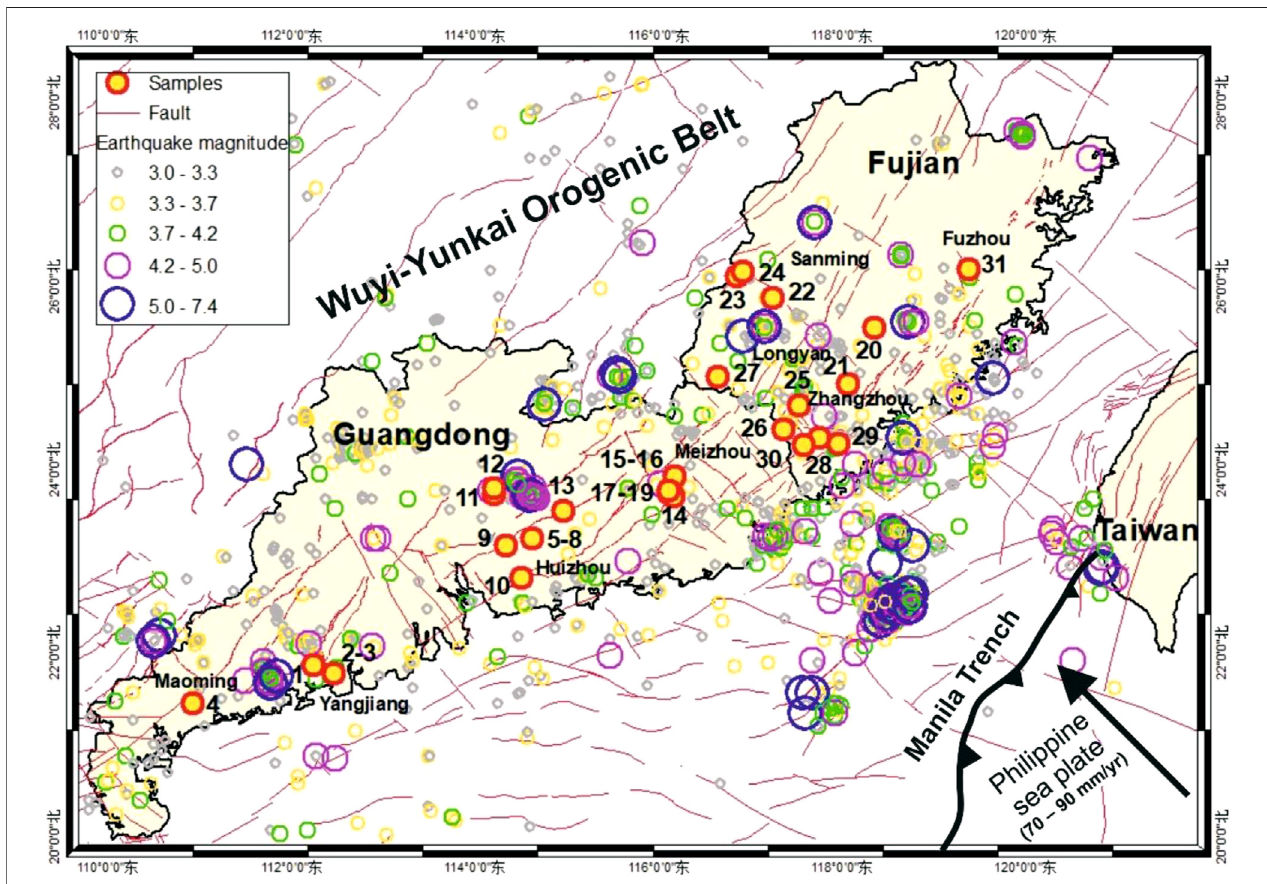
FIGURE8| EpicentersofMl > 3.0 earthquakesrecordedduring 1972 – 2021. Dataofearthquakearefrom theChinaEarthquakeNetworks Center(CENC)(Aiet al., 2019).